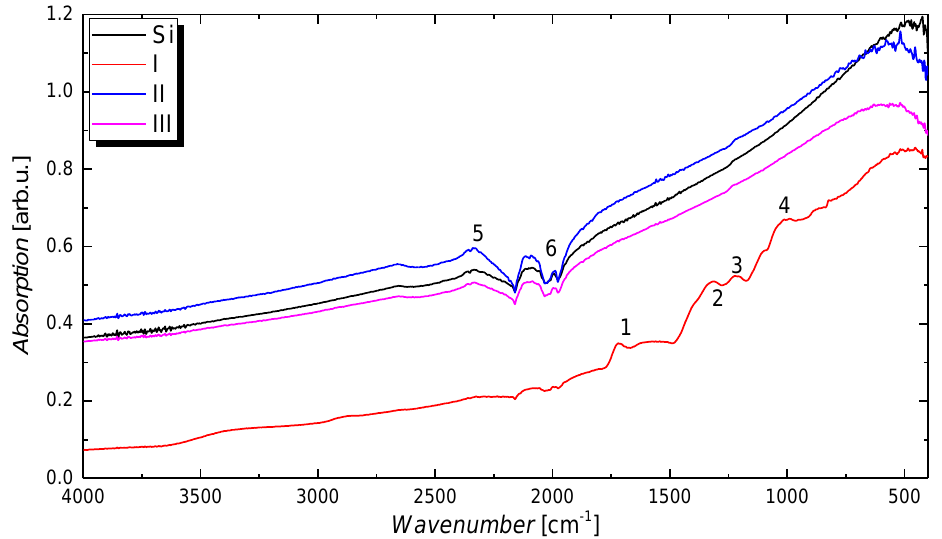
Figure 4. Fourier-transform infrared spectroscopy (FTIR) absorption spectrum for CMC-CNT films on silicon substrate subjected to the different treatments I–III. The plot includes the reference spectrum of the silicon substrate, as well as the consecutive numbering of absorption peaks that is discussed in the main text.